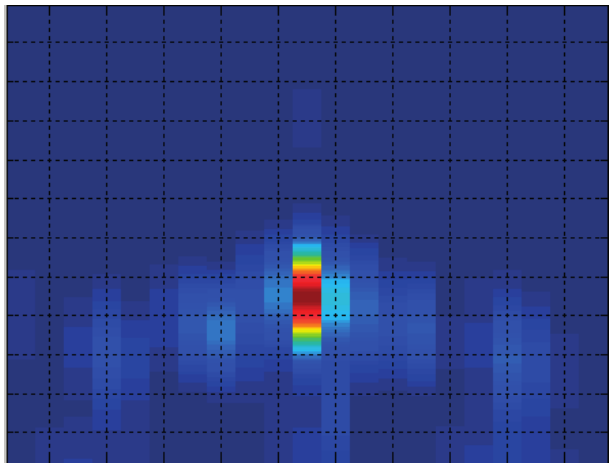
Figure 6. Acoustic image example.